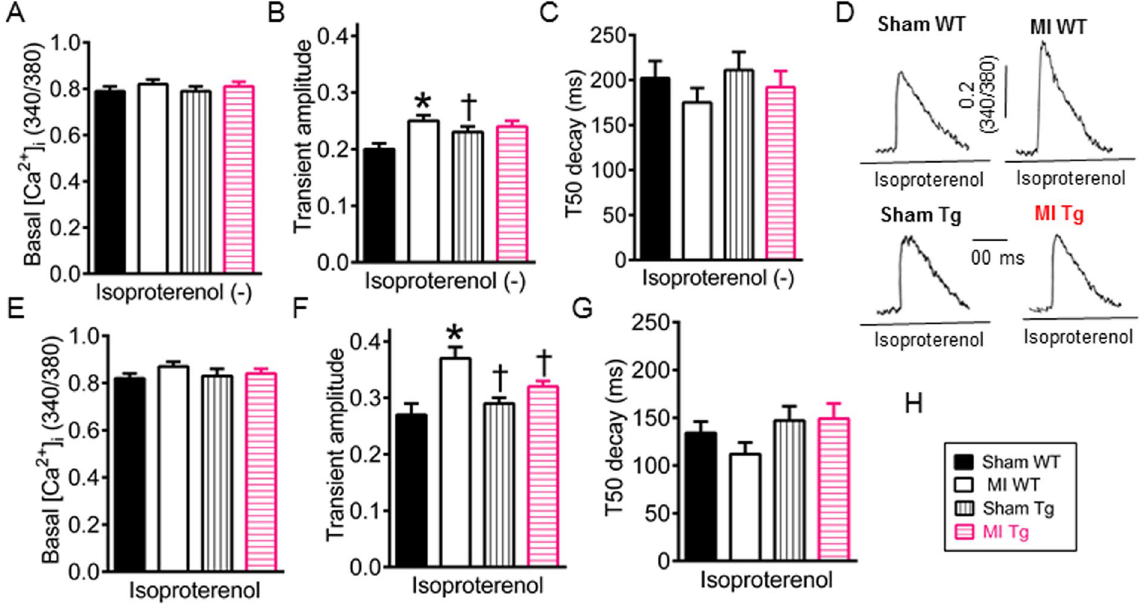
Figure 6. Effects of GTP cyclohydrolase 1 (GCH1) overexpression on intracellular [Ca 2 + ] i after myocardial infarction (MI). ( A ) Basal Ca 2 + concentrations in the absence of isoproterenol; ( B ) The amplitude of Ca 2 + transients elicited by electrical stimulation in the absence of isoproterenol; ( C ) Time to 50% decay (T50 decay) of Ca 2 + transients in the absence of isoproterenol. ( D ) Original recordings of Ca 2 + transients stimulated by electricity in the presence of isoproterenol in cardiomyocytes isolated from transgenic (Tg) and wild-type (WT) mice 4 weeks after MI or sham surgery. The vertical scale bar indicates 0.2 Fura-2 ratio (340/380 nM) unit, and the horizontal scale bar indicates 100 ms; ( E ) Basal [Ca 2 + ] i in the presence of isoproterenol; ( F ) Ca 2 + transient amplitude in the presence of isoproterenol; ( G ) T50 decay of Ca 2 + transients in the presence of isoproterenol; ( H ) Figure legend. * P < 0.05 versus sham WT groups; † P < 0.05 versus MI WT groups (n = 63–66